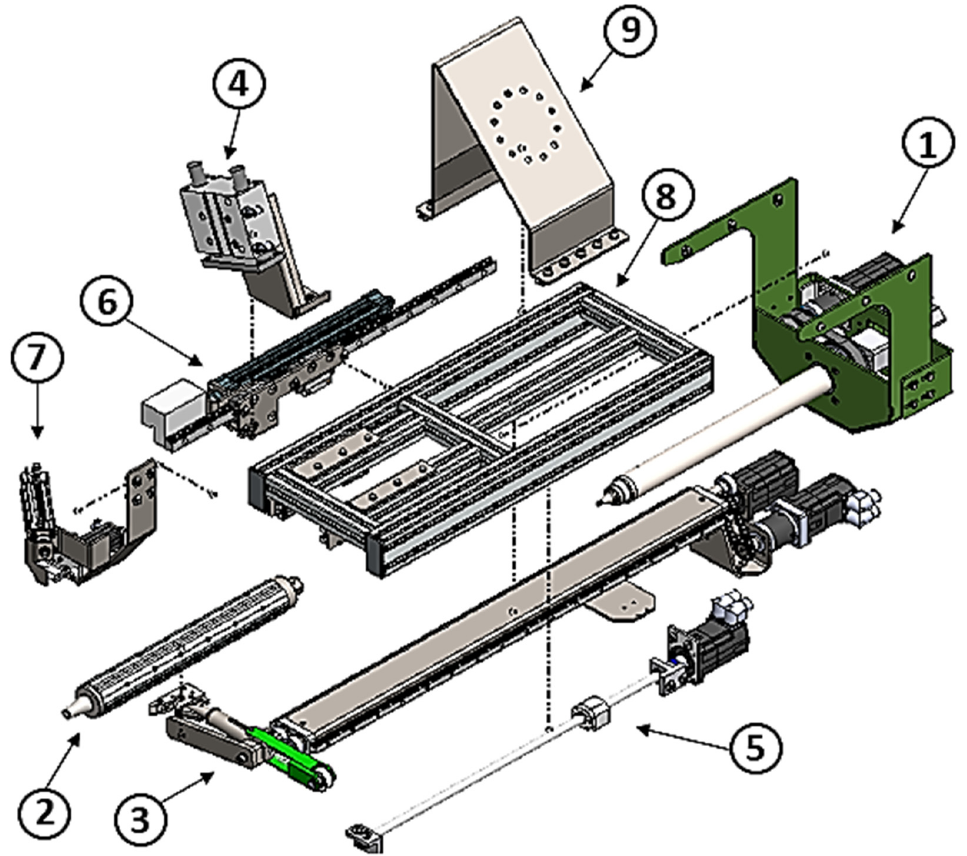
Figure 4. EOAT exploded view.